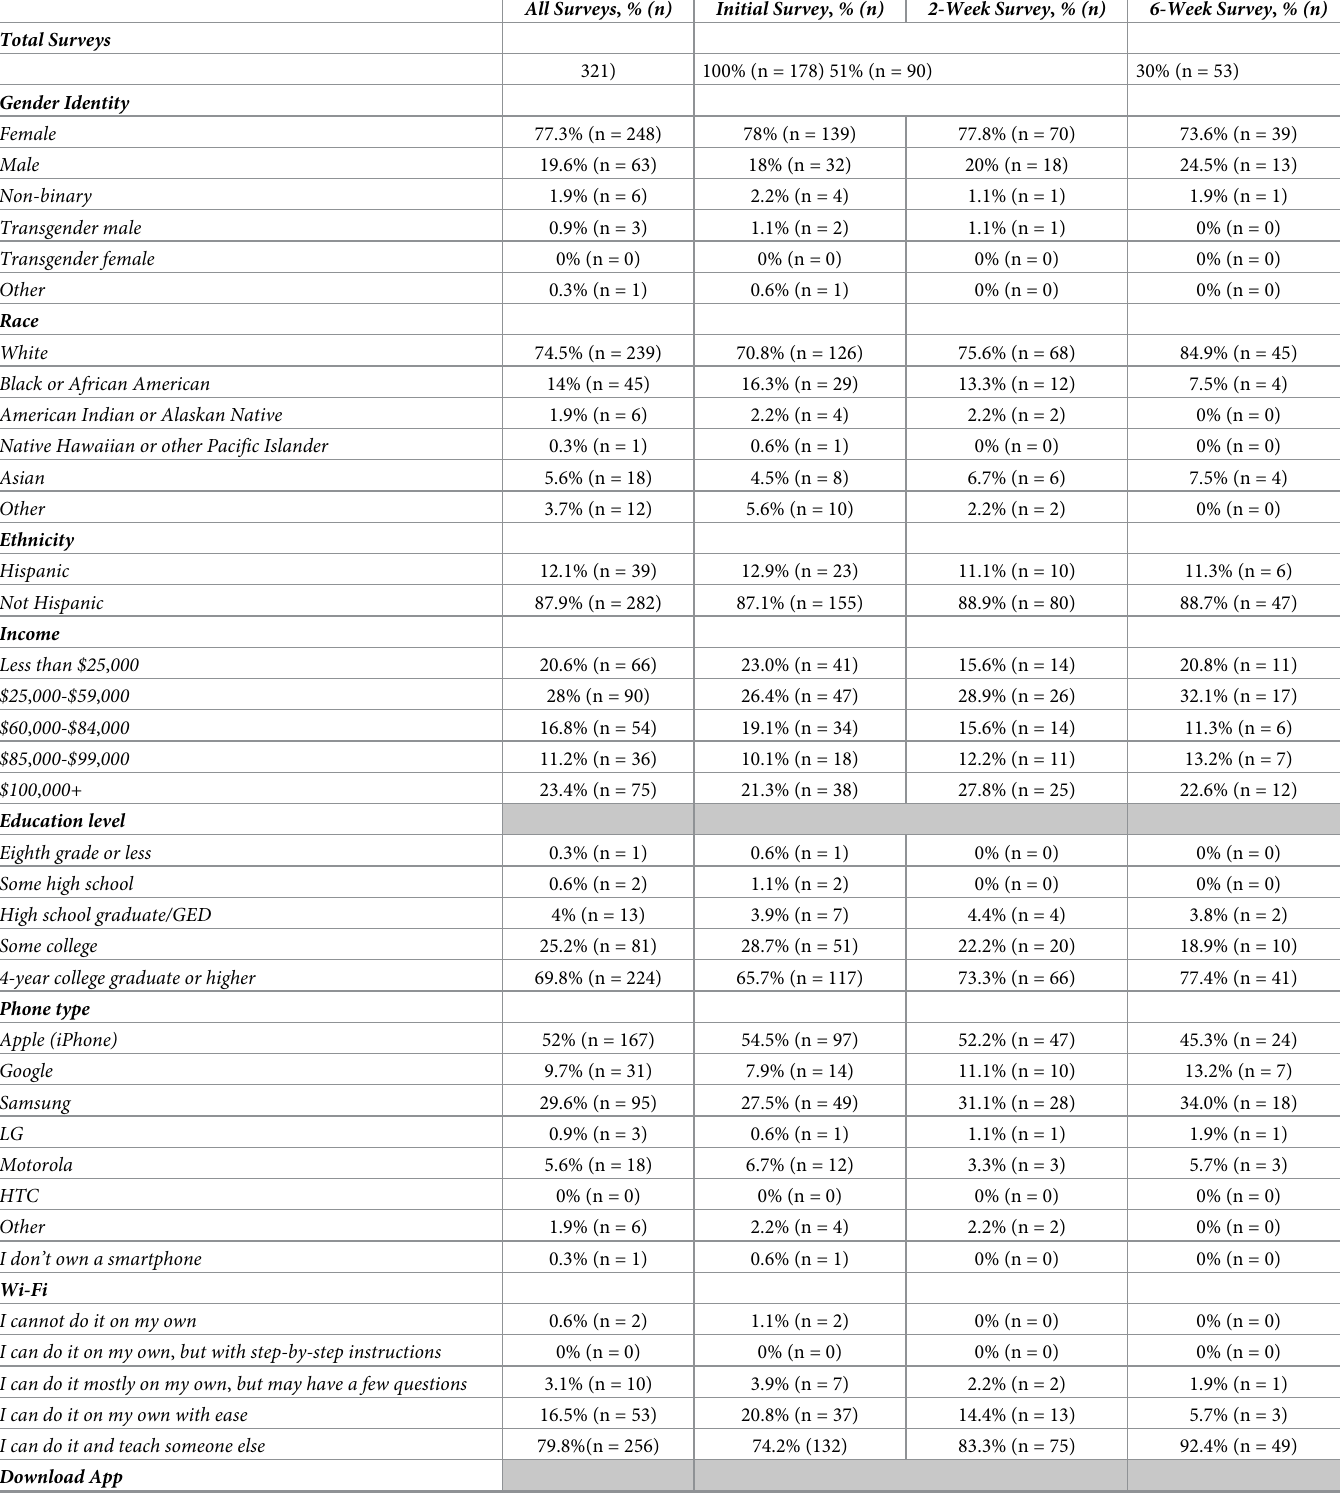
Table 1. Demographic characteristics of the sample separated into all, initial, 2-week, and 6-week